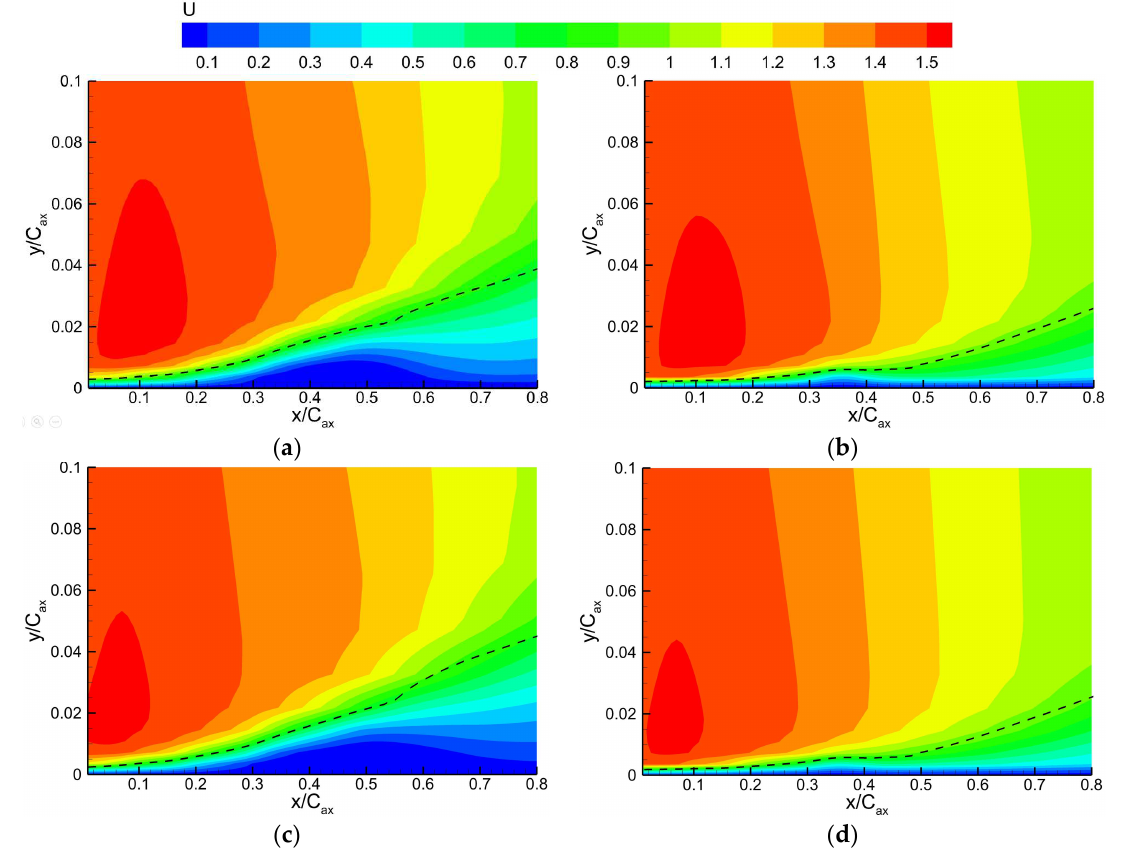
Figure 12. Distribution of mainflow velocity on the suction surface boundary layer at 50% span. ( a ) Re = 1 × 10 5 , without wake; ( b ) Re = 4 × 10 5 , without wake; ( c ) Re = 1 × 10 5 , with wake; ( d ) Re = 4 × 10 5 , with wake.